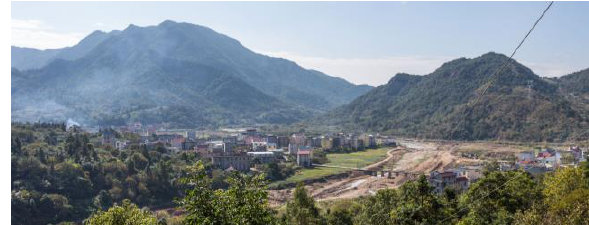
Figure 2. The village seen from Nazha Temple on Houyang Mountain. Photo by the first author.